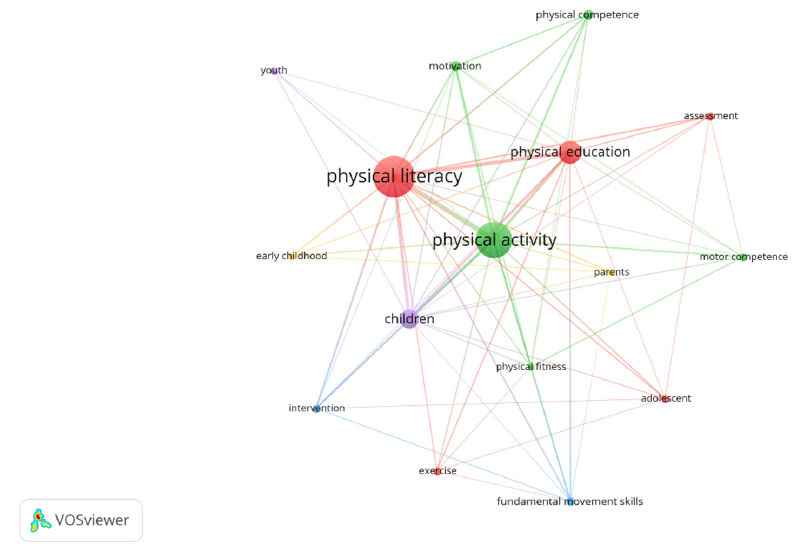
Figure 5. Authors’